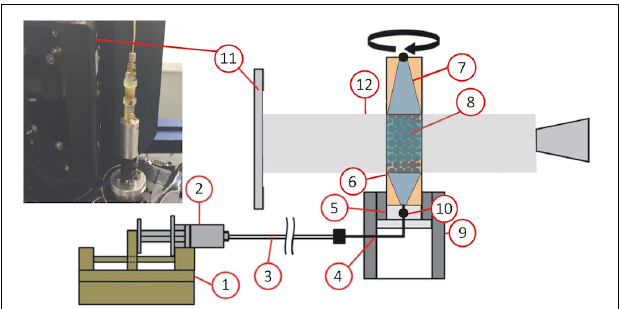
FIGURE 3 | Experimental setup used to study solute transport through porous media (modified from Setiawan et al., 2014), which includes: (1) syringe pump, (2) syringe, (3) tubing, (4) connector, (5) bottom cap, (6) flow cell printed in resin, (7) cone at the inlet and outlet, (8) sintered irregular glass beads, (9) holder, (10) pressure sensor, (11) X-ray detector, and (12) parallel